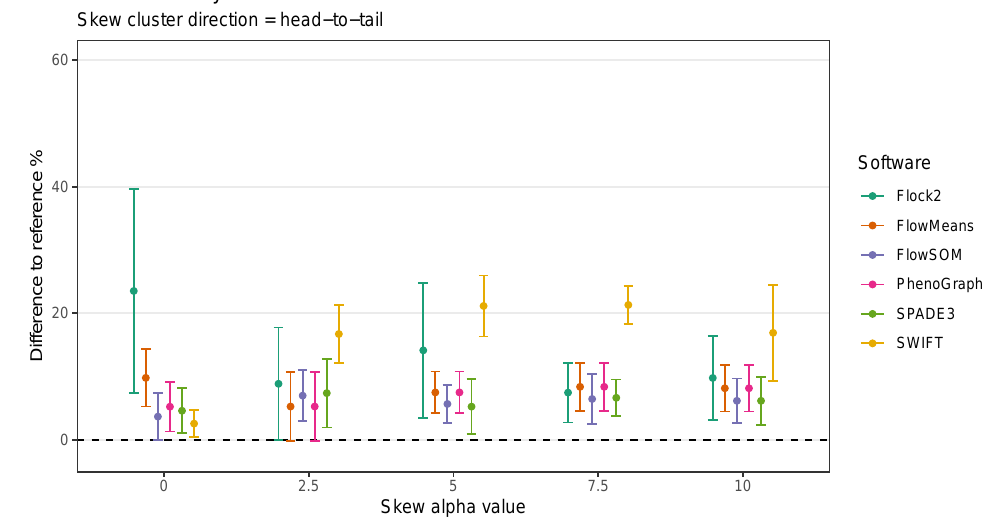
Figure 10. Performance of different software on a dataset with skew cluster orientations facing head to